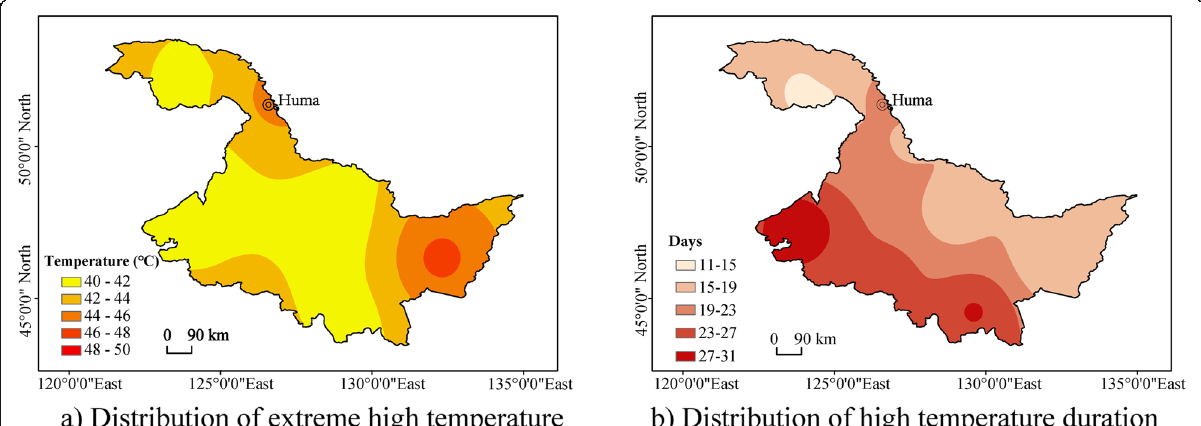
Fig. 7 Analysis scenario of once in a hundred years (Case 2). a Distribution of extreme high temperature. b Distribution of high temperature